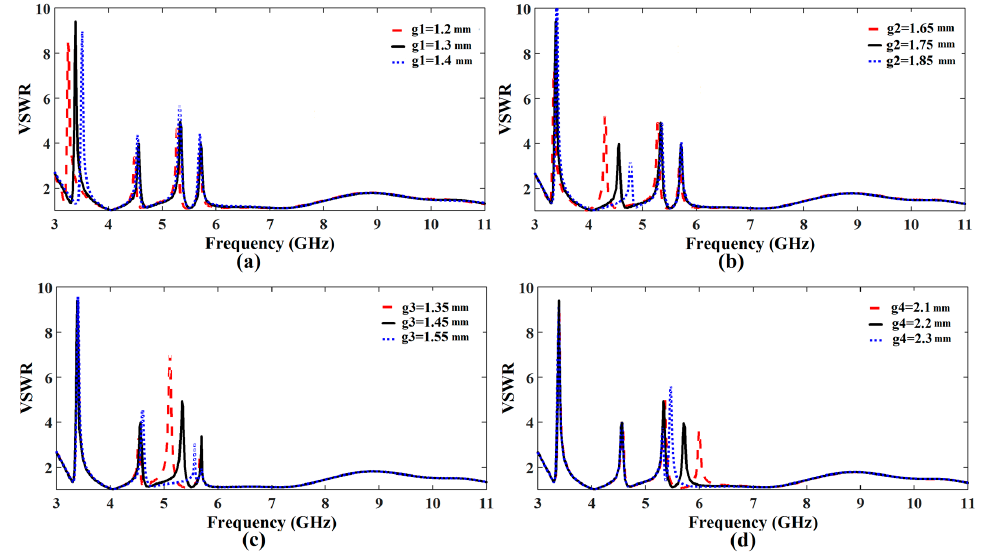
Figure 3. Notched frequency control ( a ) Adjusting notch at WiMAX frequency obtained by varying the geometrical parameter g1 ( b ) Adjusting notch at INSAT frequency obtained by varying the geometrical parameter g2 ( c ) Adjusting notch at lower WLAN frequency obtained by varying the geometrical parameter g3 ( d ) Adjusting notch at upper WLAN frequency obtained by varying the geometrical parameter g4.